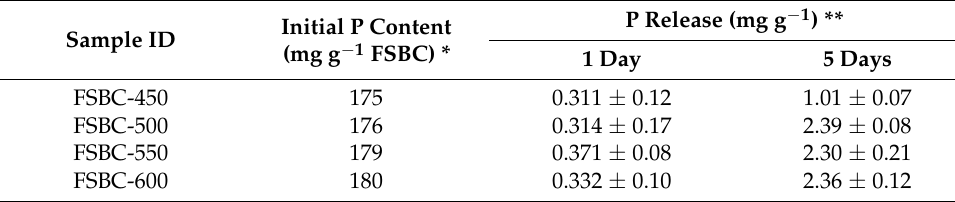
Table 3. Initial P contents of FSBC composites and P release from FSBC